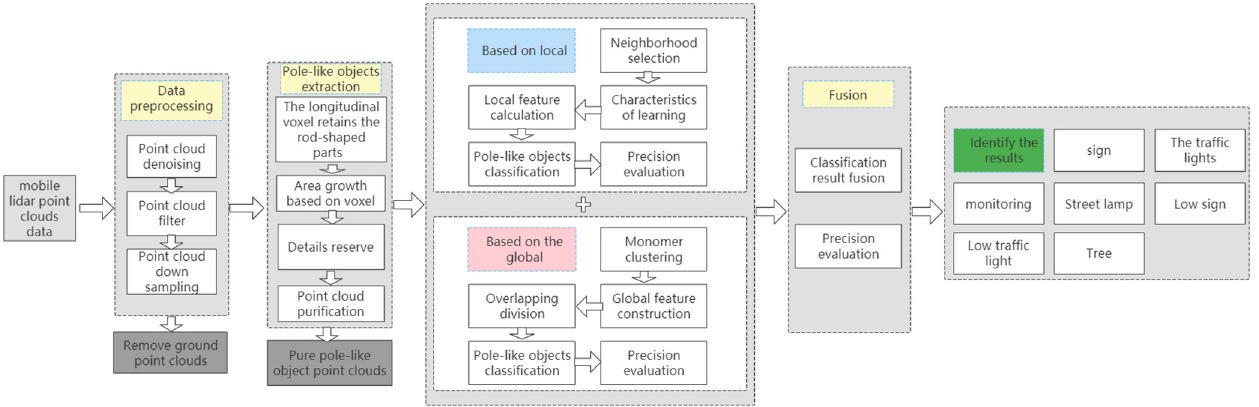
Figure 1. The framework of the proposed method.